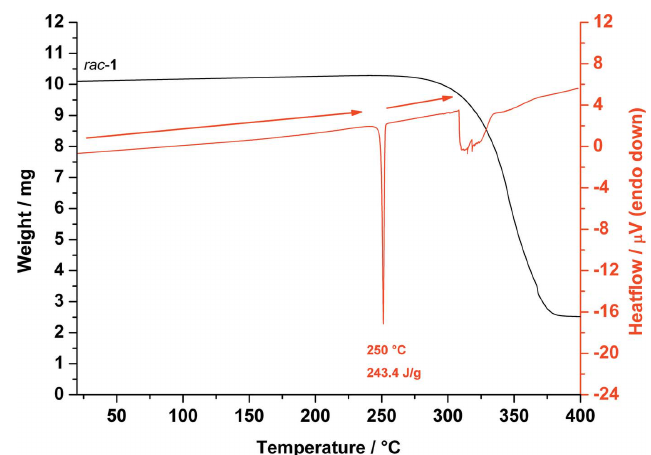
Figure 4 Combined DSC (red) and TGA (black) traces of rac - chiro -inositol ( rac - 1 ) measured from 20 to 400 (cid:2) C showing the melting of rac - 1 at 250 (cid:2) C.